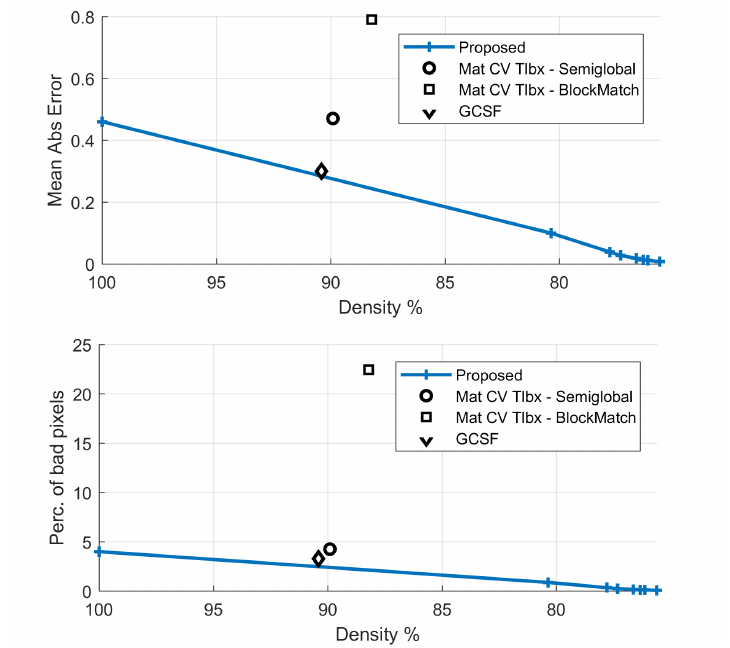
Figure 16. Natural “Xenia” sequence: Comparative results with respect to disparity